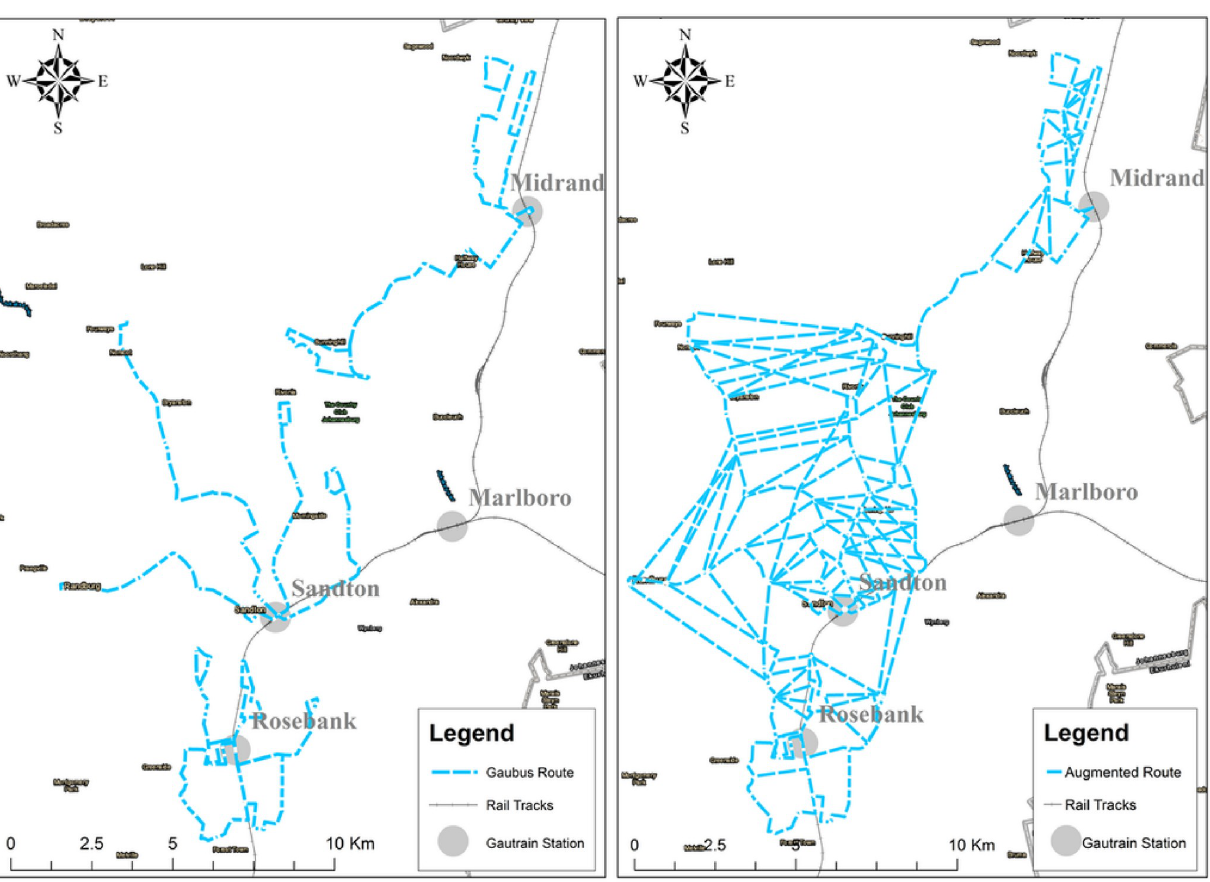
Fig 13. Original network (left) compared to the augmented network obtained with the proposed method